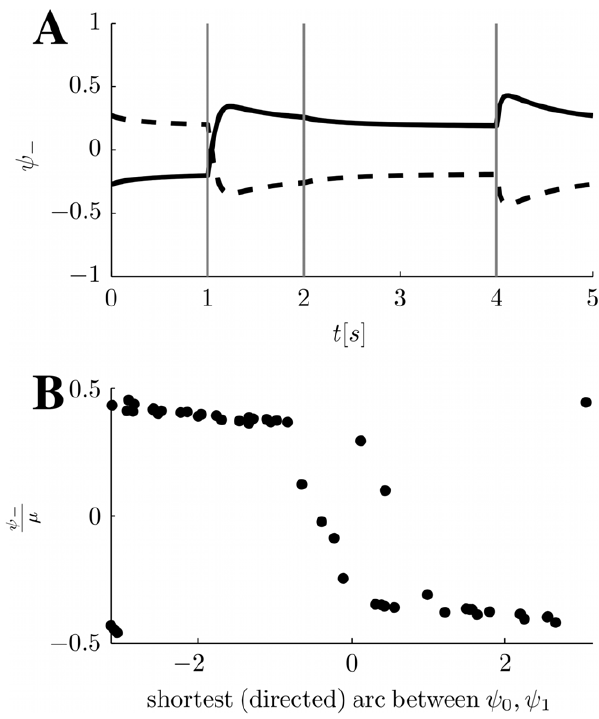
Figure 6. Solving the shortest path task. A: Two instances of MF dynamics from a network storing two correlated maps, during the presentation of two angles ( y 0 , y 1 ) with an intervening delay. The network operates inthe cylinder regime. The plotshowsthe time courseof the order parameter y { ; 0 { 1 s : pre-stimulus period, random starting y z , y { , no tuned input. 1 { 2 s : first stimulus (presented in map H A , at y 0 ~ 0 (solid and dashed). 2 { 4 s : delay period, no tuned input. 4 { 5 s : p 3 p (solid) and y 1 ~ (dashed). By looking at second stimulus y 1 ~ 2 2